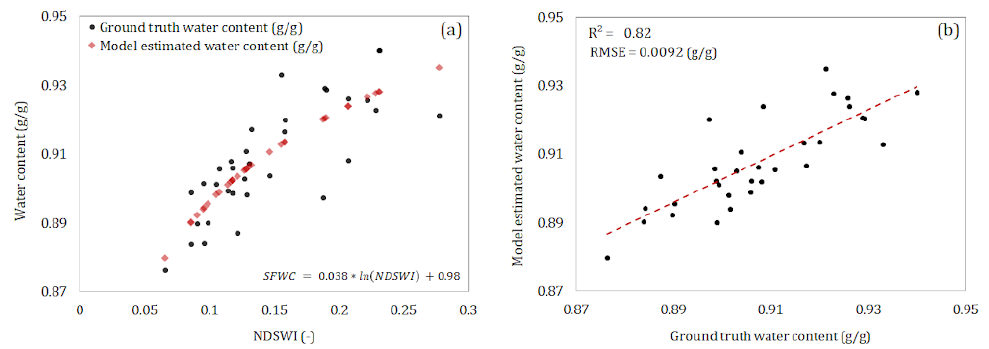
Figure 7. ( a ) Scatter plot of strawberry fruit water content model (SFWC) result and ground truth strawberry fruit water content, against normalized difference strawberry water content index (NDSWI). ( b ) Scatter plot between ground truth and estimated strawberry water content.